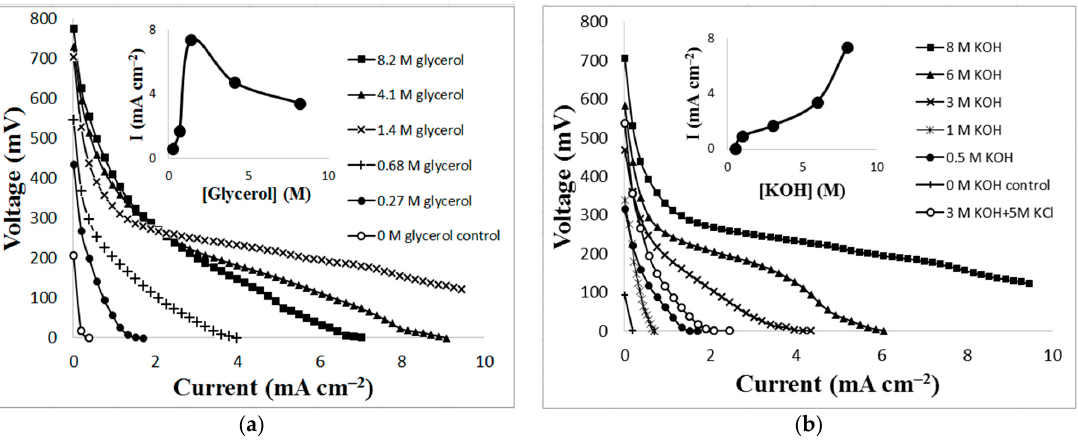
Figure 3. ( a ) Polarization curve of various concentrations of glycerol in 8 M KOH solution; ( b ) Various concentrations of KOH in 1.4 M glycerol.